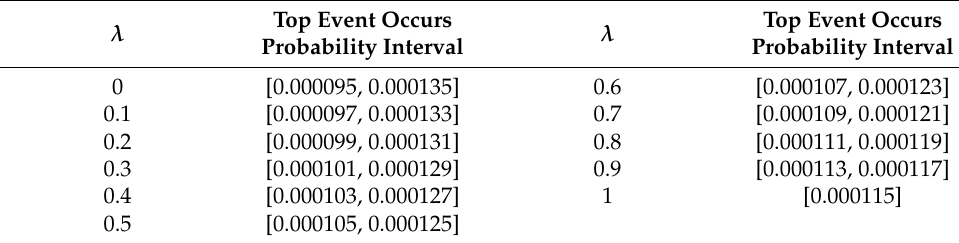
Table 4. Top event probability intervals according to the value of λ . Top Event Occurs λ